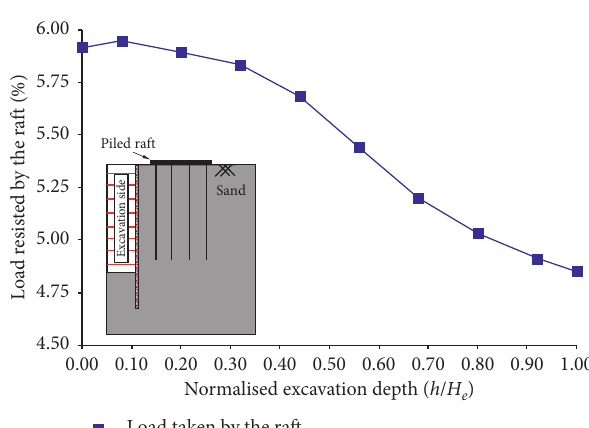
Figure 10: Changes in load resisted by the raft during